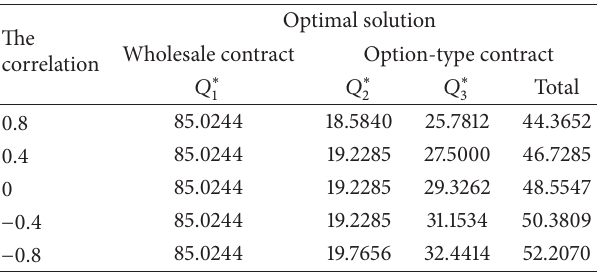
Table 3: Effect of correlation between market liquidity and